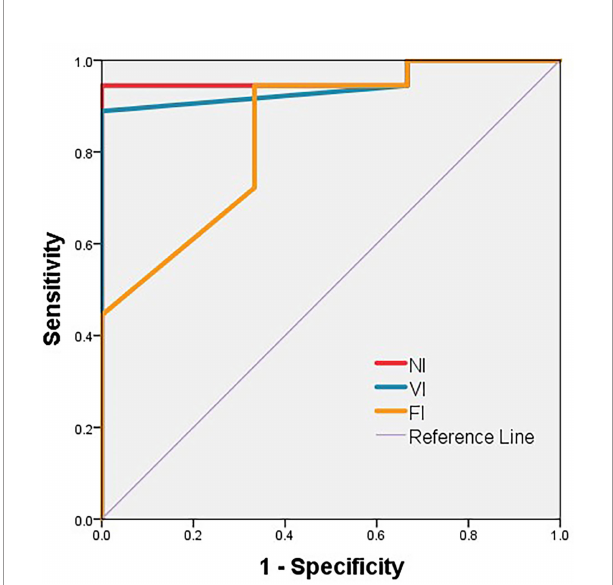
FIGURE 5 | ROC curve of NI, VI, and FI. The area of ROC curve of NI, VI, and FI are 0.963, 0.944, and 0.843, respectively. The P-values are 0.012, 0.016, and 0.063, respectively. FI, fractional anisotropy index; NI, fi ber number index; VI, fi ber volume